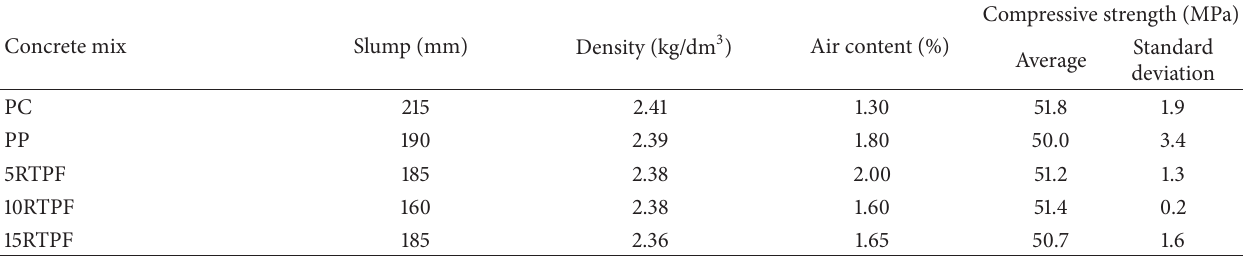
Table 4: Fresh concrete properties and compressive